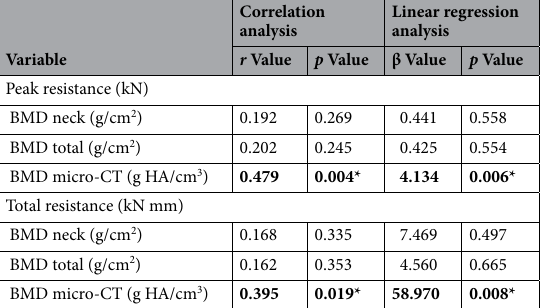
Table 5. Correlation and linear regression analysis between the bone mineral densities and resistance properties. r , correlation coefficient; p, significance; β, standardized coefficient. Significant values are in